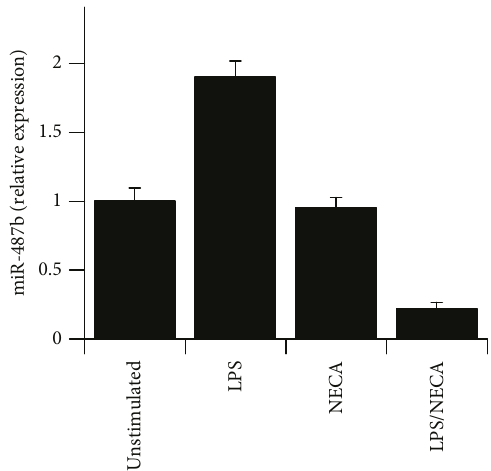
Figure 2: TaqMan Q-RT-PCR assays were performed using RNA samples from untreated macrophages or macrophages treated with LPS (100ng/ml), NECA (1 μ M), or LPS (100ng/ml) with NECA (1 μ M) for 12 hours. Samples from 3 separate experiments were each analyzed in duplicate, with data indicating mean fold change relative to untreated macrophages ± SE . Expression levels were normalized to the expression of cyclophilin-D as a housekeeping